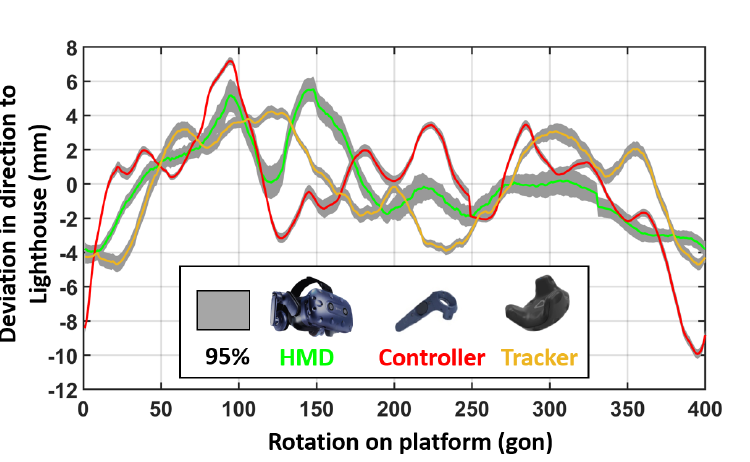
Figure 17. Horizontal position variation in direction to the lighthouse for different VR devices. Distance to lighthouse: 2